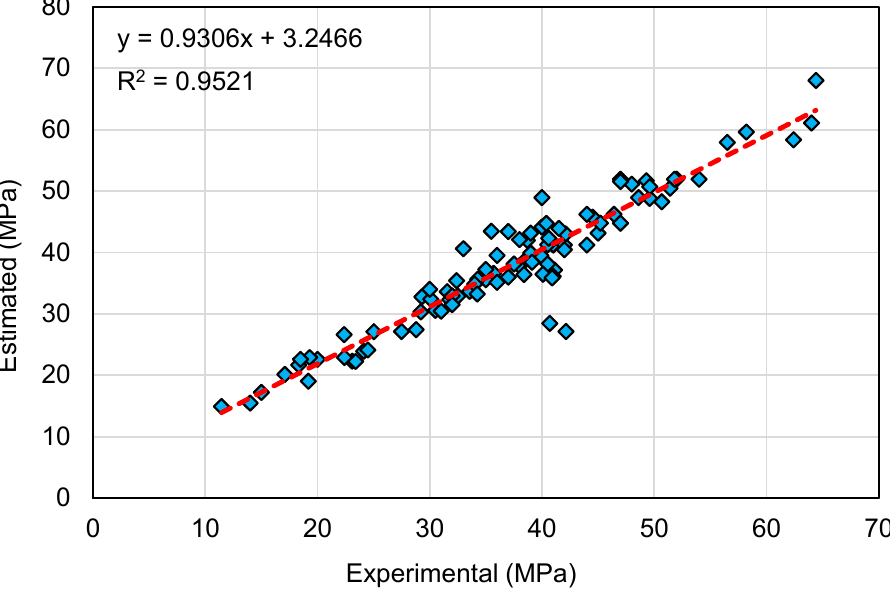
Figure 14. Relationship between experimental and estimated outcomes for the random forest model.